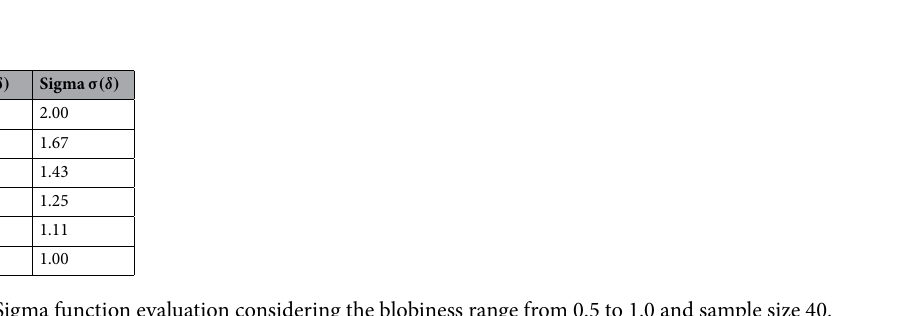
Table 2. Sigma function evaluation considering the blobiness range from 0.5 to 1.0 and sample size 40.